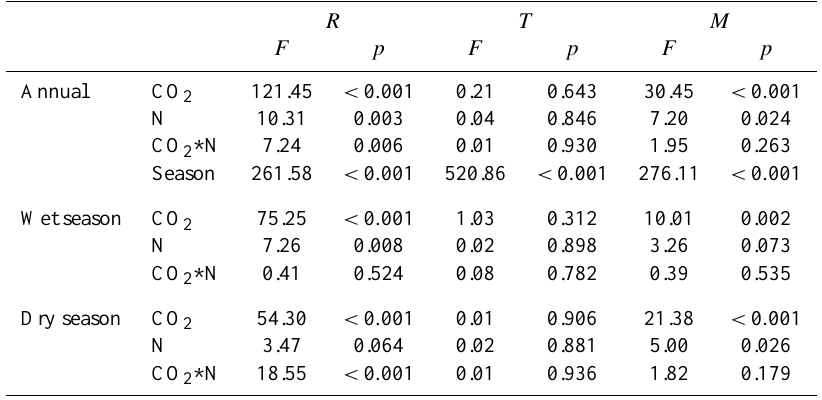
Table 2. Significance of the impacts of CO 2 (effect of individual elevated [CO 2 ]), N (effect of individual N addition), CO 2 *N (the interactive effect between elevated [CO 2 ] and N addition) and season on soil respiration ( R ), soil temperature ( T ) and soil moisture ( M ) in the repeated measures ANOVA.